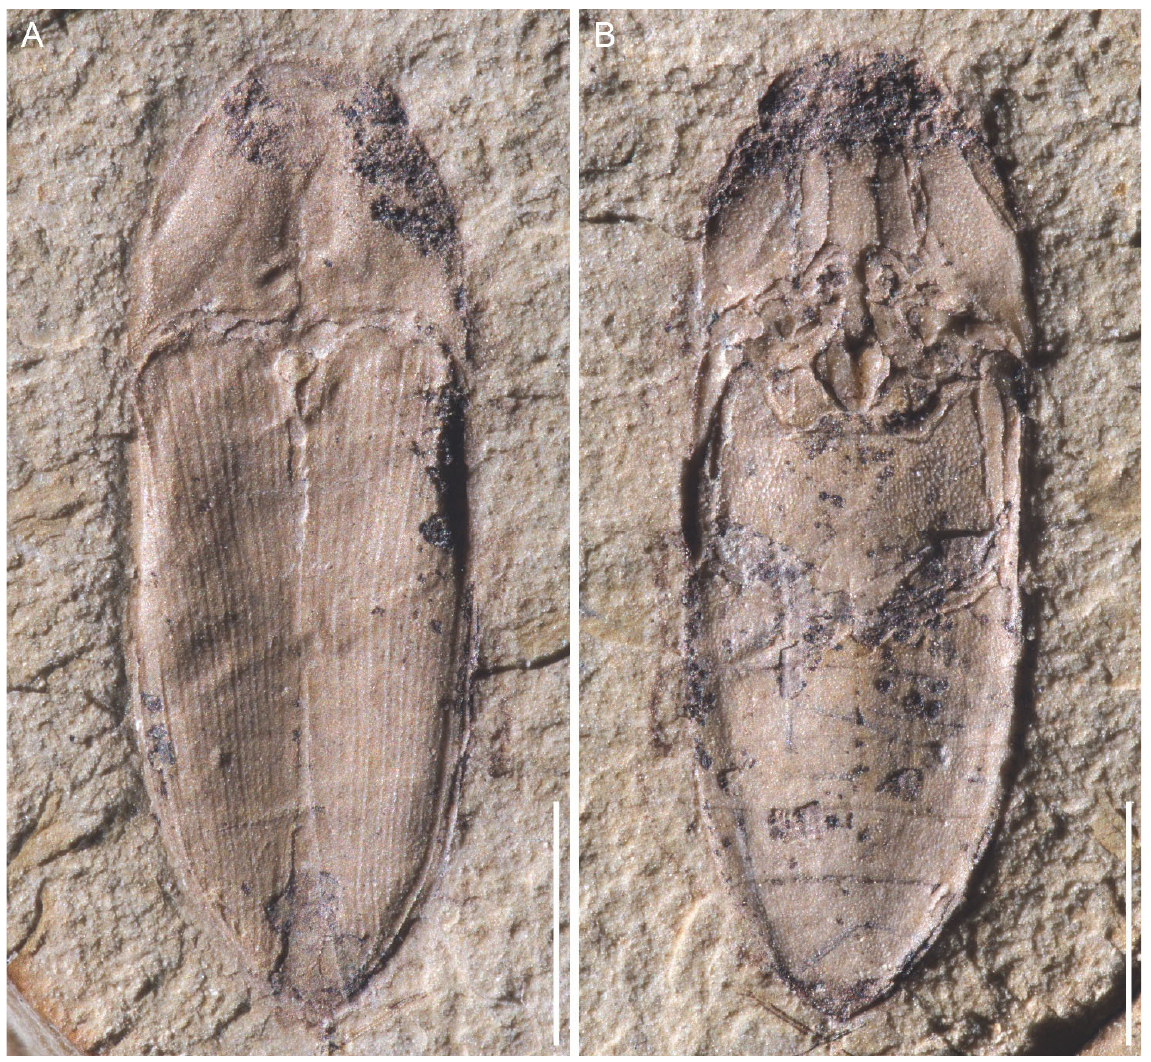
Figure 1. General habitus of Archaeolus funestus Lin, 1986, holotype, NIGP70071, under incident light. ( A ) Part, NIGP70071a. ( B ) Counterpart, NIGP70071b. Scale bars: 1 mm.